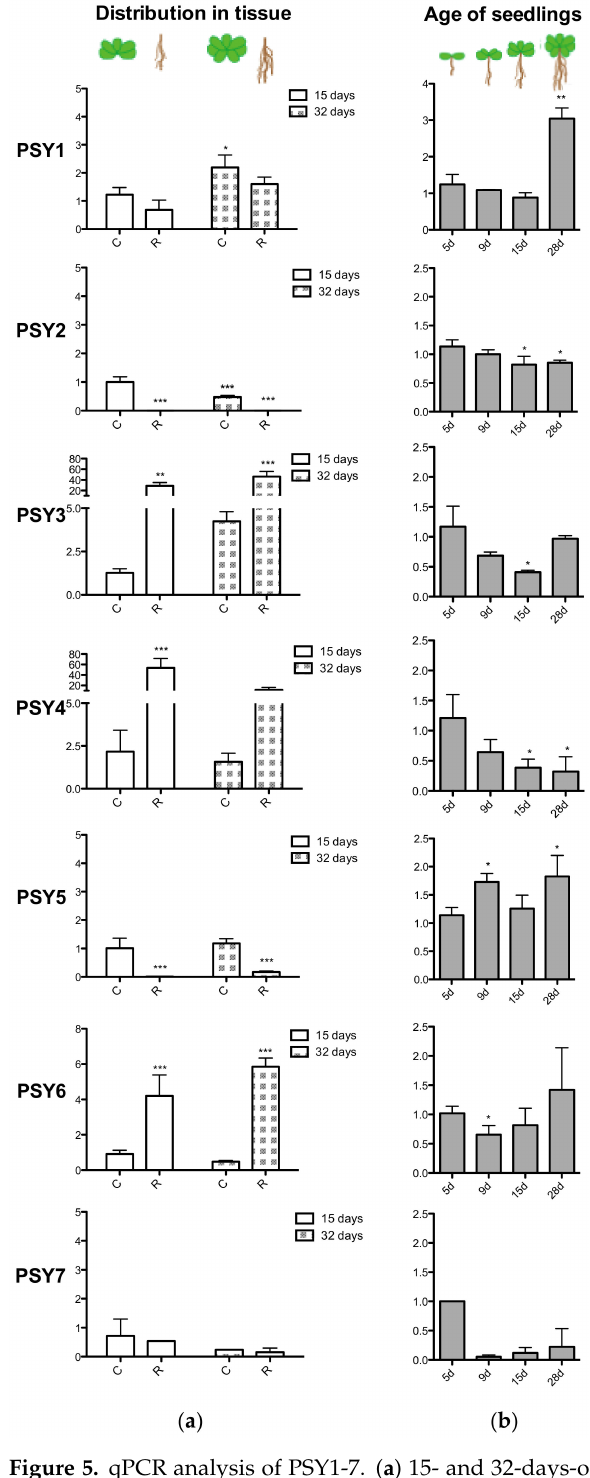
Figure 5. qPCR analysis of PSY1-7. ( a ) 15- and 32-days-old seedlings divided into shoot (C) and roots (R) before RNA collection. ( b ) RNA collection of entire seedlings after 5, 9, 15 and 28 days. Transcript levels were normalized to actin and relative to ( a ) the 15d cotyledon sample and ( b ) the 5d sample. Note that the y-axis units differ. Statistical analysis was done with One-way ANOVA, Dunett’s post-test with ( a ) the 15d shoot sample and ( b ) the 5d sample as reference. PSY7 expression was nearly not detectable and a transcript level of 1 is not comparable. * indicates p < 0.05, ** indicates p < 0.01, *** indicates p < 0.001. PSY8 was identified at a late stage and was therefore not included in the qPCR